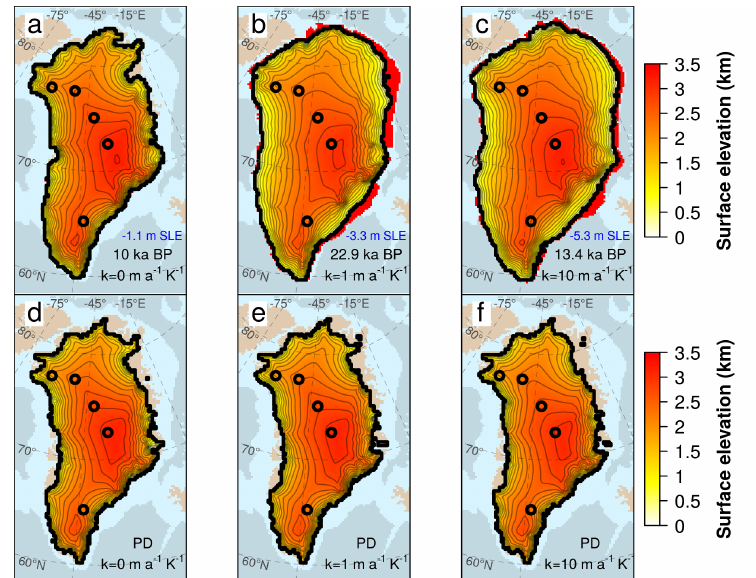
Figure 7. GrIS surface elevation (km) simulated at the LGM (TI) (a–c) and present-day GrIS (d–f) for three values of the heat-flux coefficient κ having set B ref = 1ma − 1 . The timing of the snapshots depends on the experiment and is stated in black for each snapshot. Corresponding ice volume (in s.l.e.) is shown in blue. Red zones represent the ice shelves extending beyond the LGM grounding line (black line). Black circles indicate the locations of the Camp Century, NEEM, NGRIP, GRIP and Dye3 ice cores (from north to south).